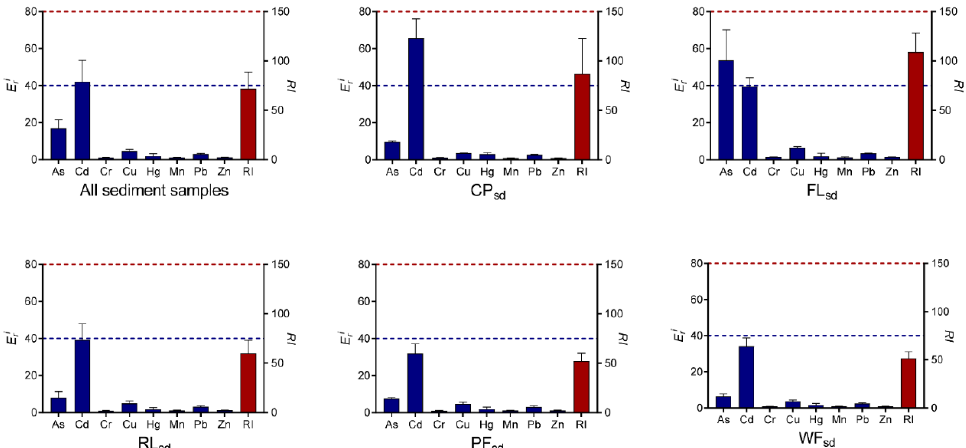
Figure 5. The potential ecological risk index ( RI , E ri ) of metals in sediment samples that were associated with five types of land use (CP, FL, RL, PF, and WF). The blue bar-plot on the left Y-axis represents the mean E ri values of the 10 or 50 replicate samples per metal, and the blue dashed line indicates E ri = 40. The red bar-plot on the right Y-axis represents the mean RI value of the 10 or 50 replicate samples, and the red dashed line indicates RI = 150.